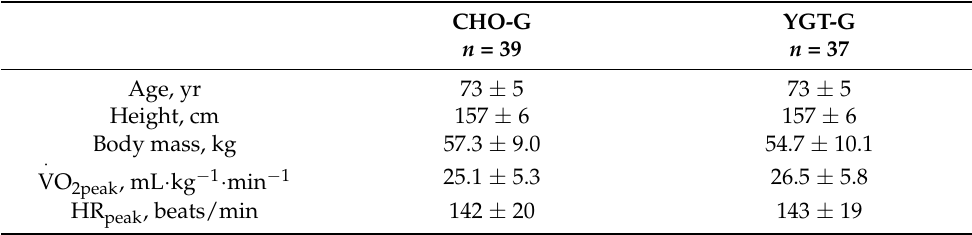
Figure 1. CONSORT flow diagram. CHO-G, the carbohydrate intake group; YGT-G, the yogurt intake group. Table 1. Physical characteristics of subjects by group.